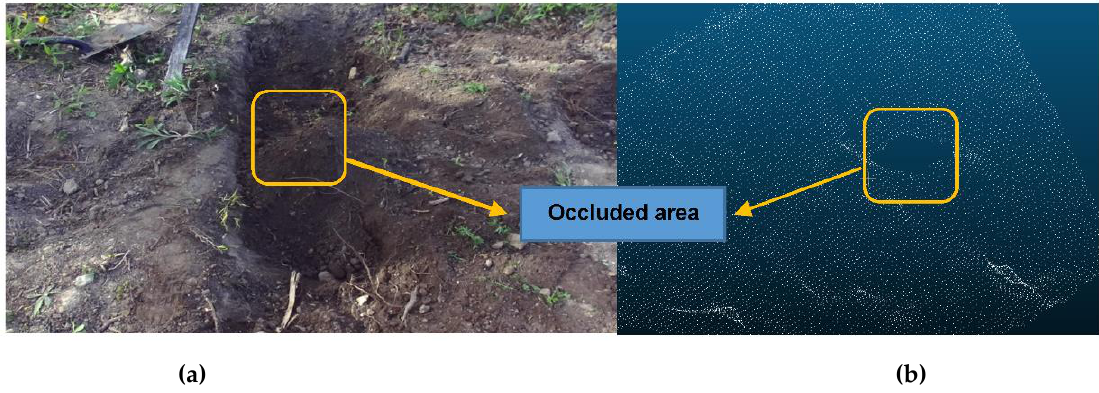
Figure 3. Example of an occluded region on the excavation site: ( a ) Indication of a pile that blocks the sensor vision causing occlusion; ( b ) Initial exteroceptive map using LiDAR sensory data (point cloud) for the same site that includes the identical occlusion region.